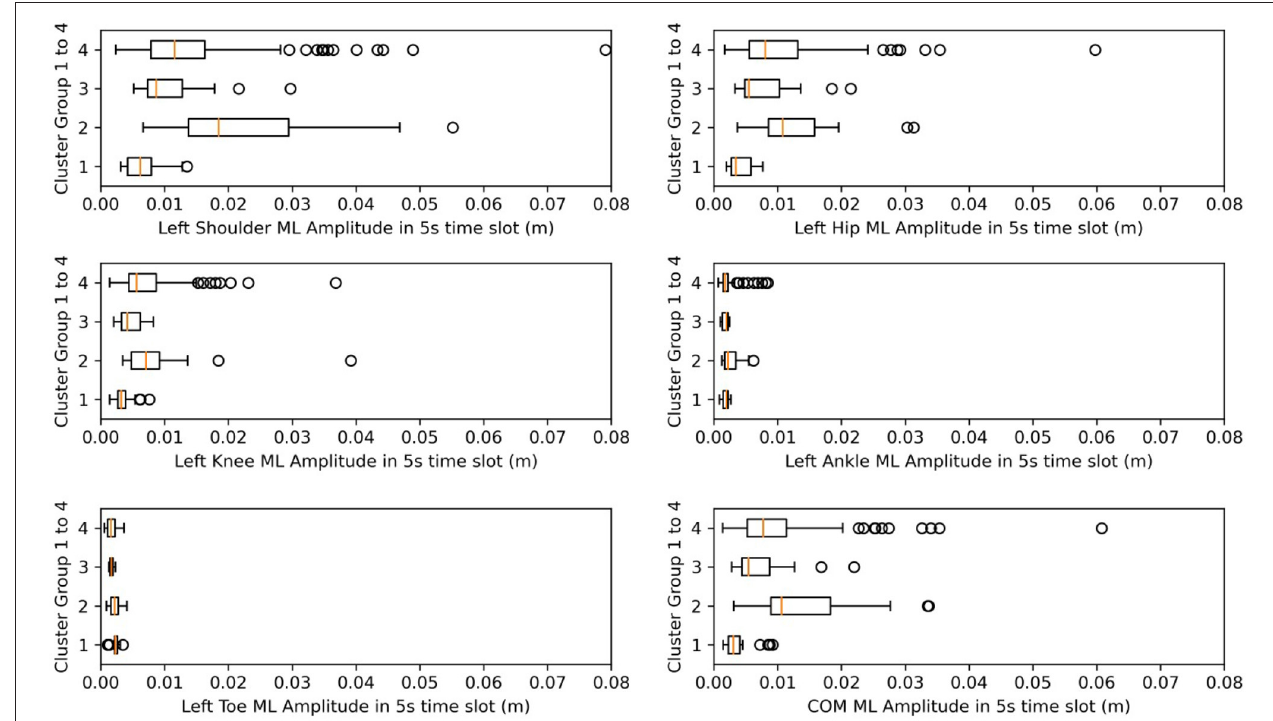
FIGURE 8 | Box plots for amplitude in ML. X-axes represent the amplitude after normalization in the ML